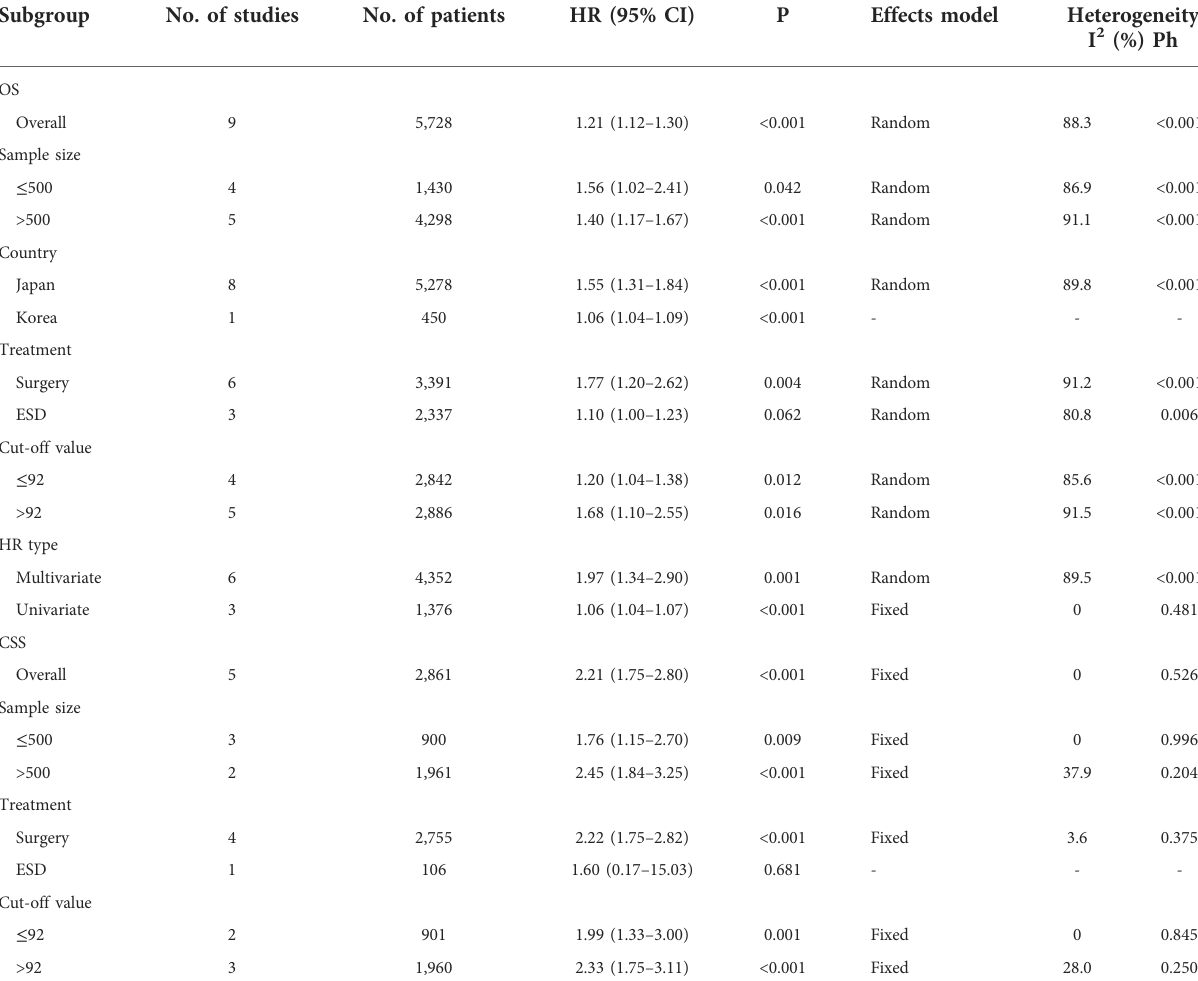
TABLE 2 Subgroup analysis of prognostic value of GNRI for OS and CSS in patients with gastric cancer.